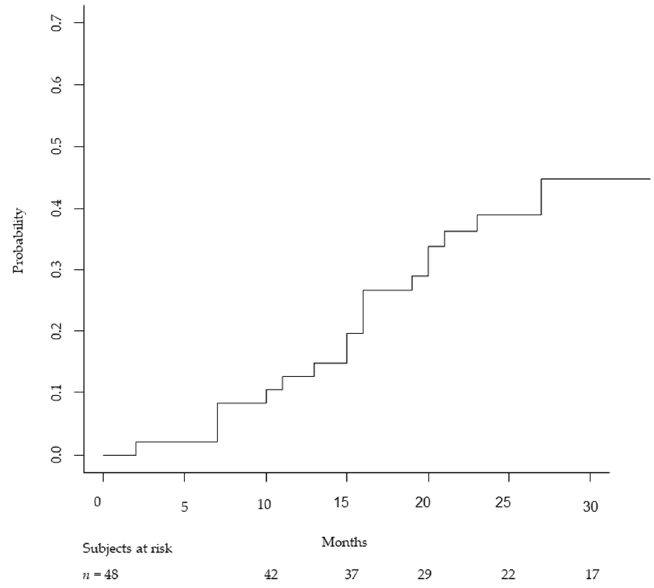
Figure 1. Cumulative incidence showing the cumulative brain injury (G1 and G2) rates over time in PT and CIRT.